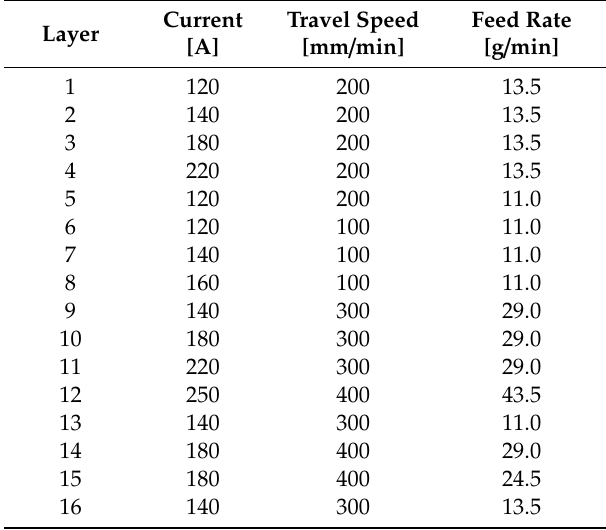
Table 2. Test processing